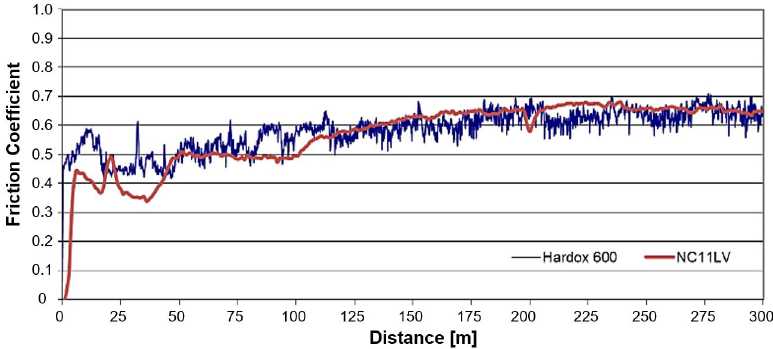
Figure 9. Coefficients of friction in a ball-on-disc trial for both analyzed